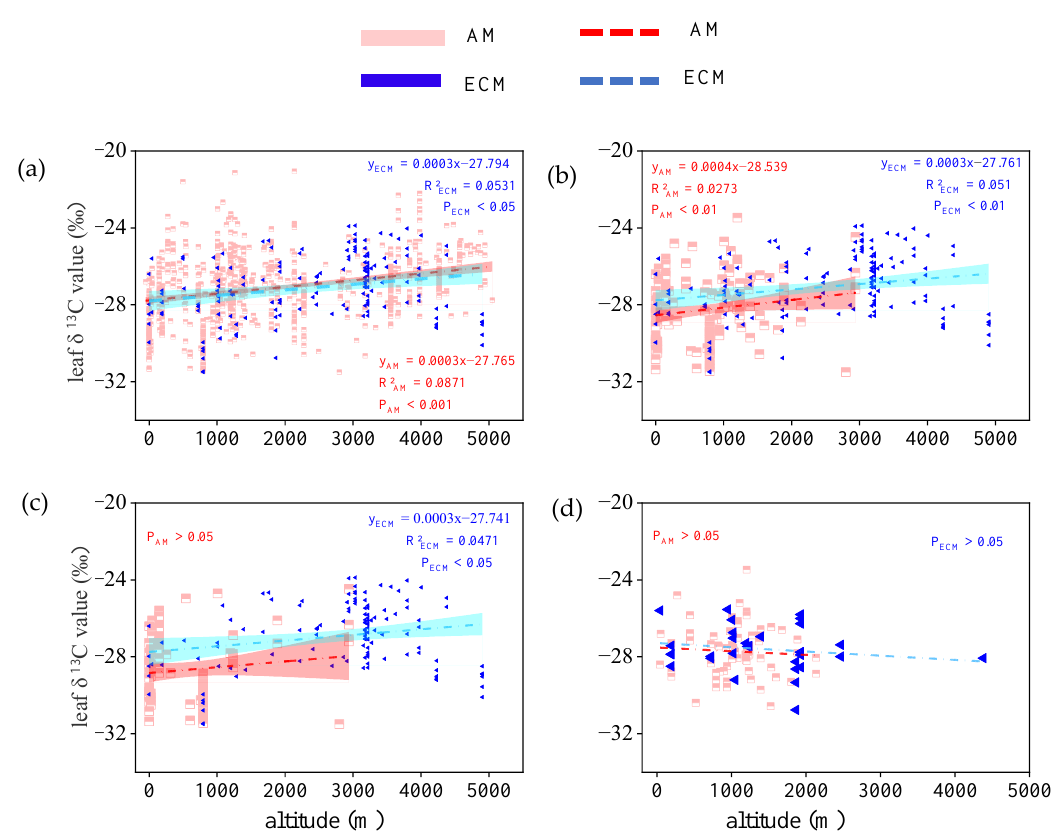
Figure 7. The relationship between leaf δ 13 C in AM plants and ECM plants with different life forms and altitudes (m). ( a ) Total plants, include all plants in the database without distinguishing their life forms. ( b ) Trees, only contain all the tree species in the database. ( c ) Evergreen trees, only contain all evergreen trees of the tree species. ( d ) Deciduous trees, only contain all deciduous trees of the tree species. The red broken line means AM, the blue broken line means ECM. The red and cyan bands represent, respectively, the prediction intervals of AM and ECM plants. P( AM and ECM ) represents the significant difference in the slope of the two regression lines.